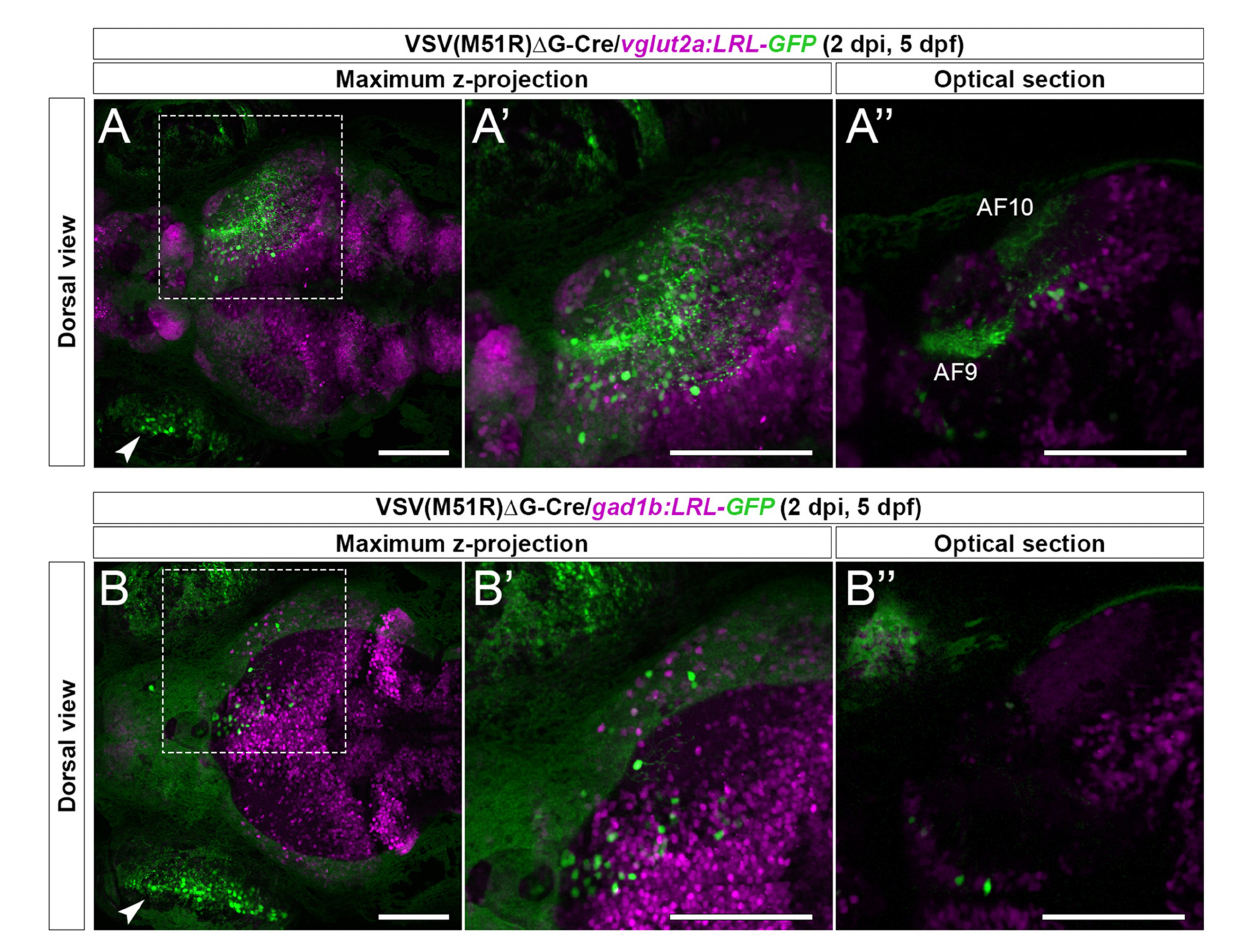
FIGURE 2 | Cre-dependent TRAS-M51R labeling of specific retinorecipient neuron subtypes. (A–A”) Representative image of a 2 dpi (5 dpf) live vglut2a:LRL-GFP larvae injected with VSV(M51R) ∆ G-Cre. Boxed area in (A) is shown in higher magnification in ( A’ ; both show maximum z-projection). Panel (A”) shows a single optical section in the box area in (A) , at the level of AF9. GFP expression was seen in the injected eye (arrowhead in A ), retinorecipient cells (round green cells), and the AFs (AF9 and AF10 shown in A” ). (B–B”) Representative image of a 2 dpi (5 dpf) live gad1b:LRL-GFP larvae injected with VSV(M51R) ∆ G-Cre. Boxed area in (B) is shown in higher magnification in (B’) (both show maximum z-projection). Panel (B”) shows a single optical section in the box area in (B) , at the level of AF9. GFP expression was seen in the injected eye (arrowhead in B ) and retinorecipient cells. No AF labeling was seen. Green fluorescence in the uninjected eye was from the autofluorescence of retinal pigment epithelial cells. Scale bars are 100 µ